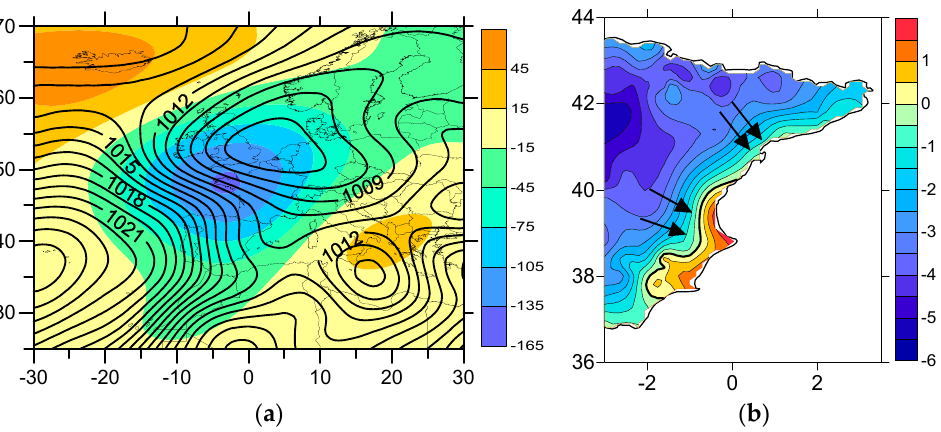
Figure 6. ( a ) MSLP (hPa) and Z500 (gpm) anomalies (iPCN2 < 10th percentile); ( b ) Average value of the Tx anomalies in the east IP (iPCN2 < 10th percentile). The positive Tx anomalies of the SE IP are to the right of the thick line. Black arrows represent the direction of the air flux.